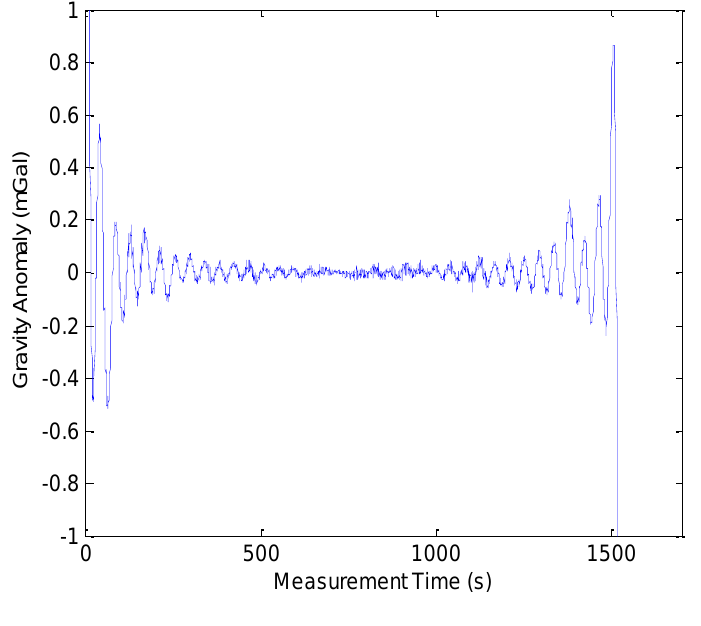
Figure 11. Reconstruction error of OMP in